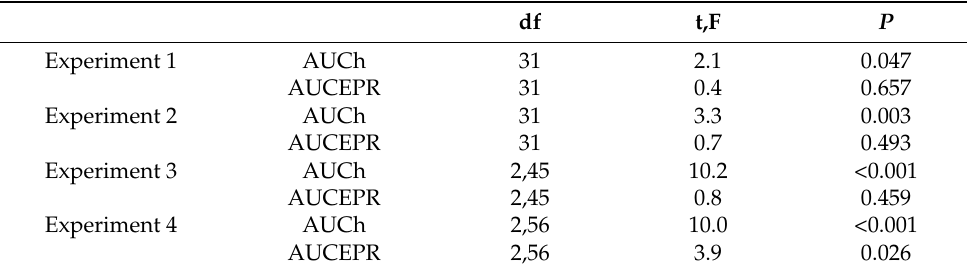
Table 1. Student’s t -test or one-way ANOVA results testing the effects of deprenyl and PCPA on the area under the curve (AUC) values obtained from Daphnia photomotor responses to repetitive light stimuli. AUCEPR and AUCh are, respectively, the areas of enhanced photomotor responses during the first 10 light stimuli and during habituation afterwards. Results for the four identical experiments are reported.